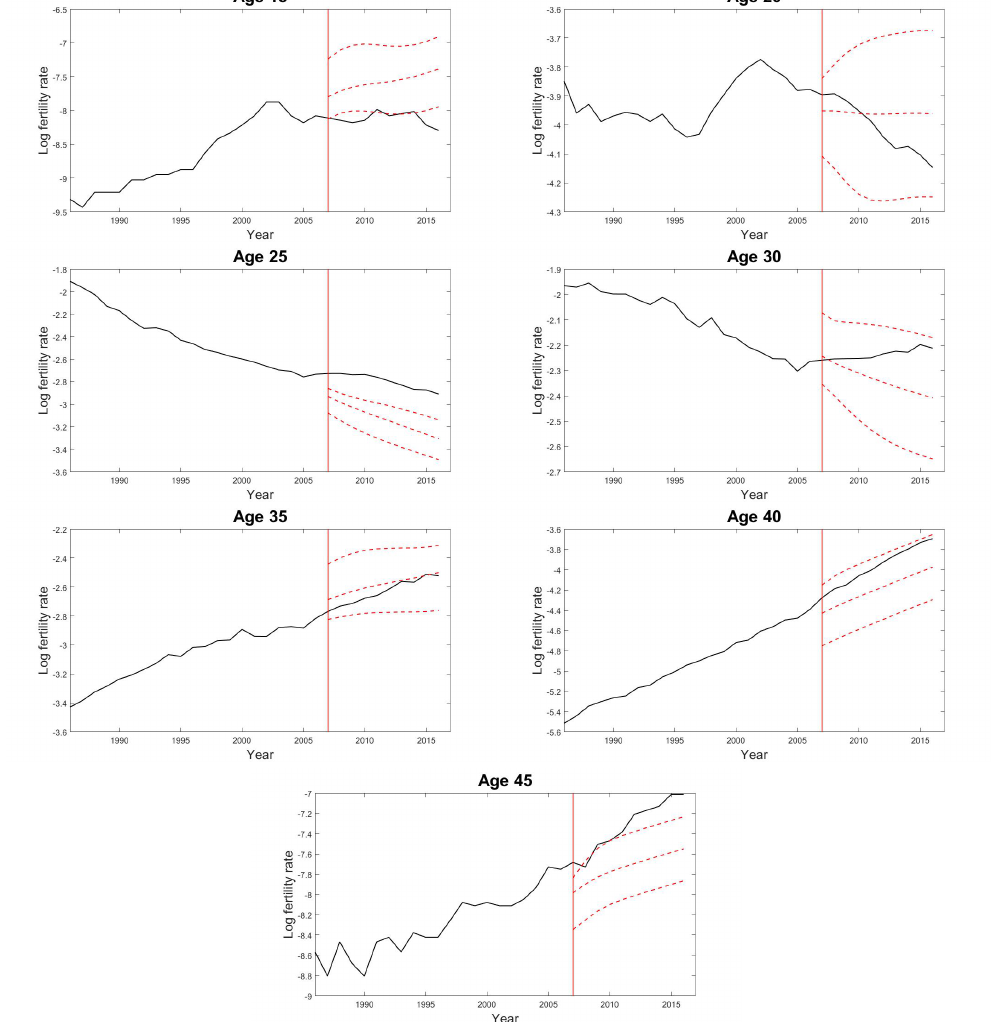
Figure 5. Predicted fertility rates of the selected age groups from age 15 to age 45 with 5-year age intervals using the GPR model from the year 2007 to the year 2016 based on the observations from the year 1947 to the year 2006 in Japan. The solid lines are the observed values, and the dashed lines are the predictions and the 95% prediction intervals. The vertical line indicates the starting point of the